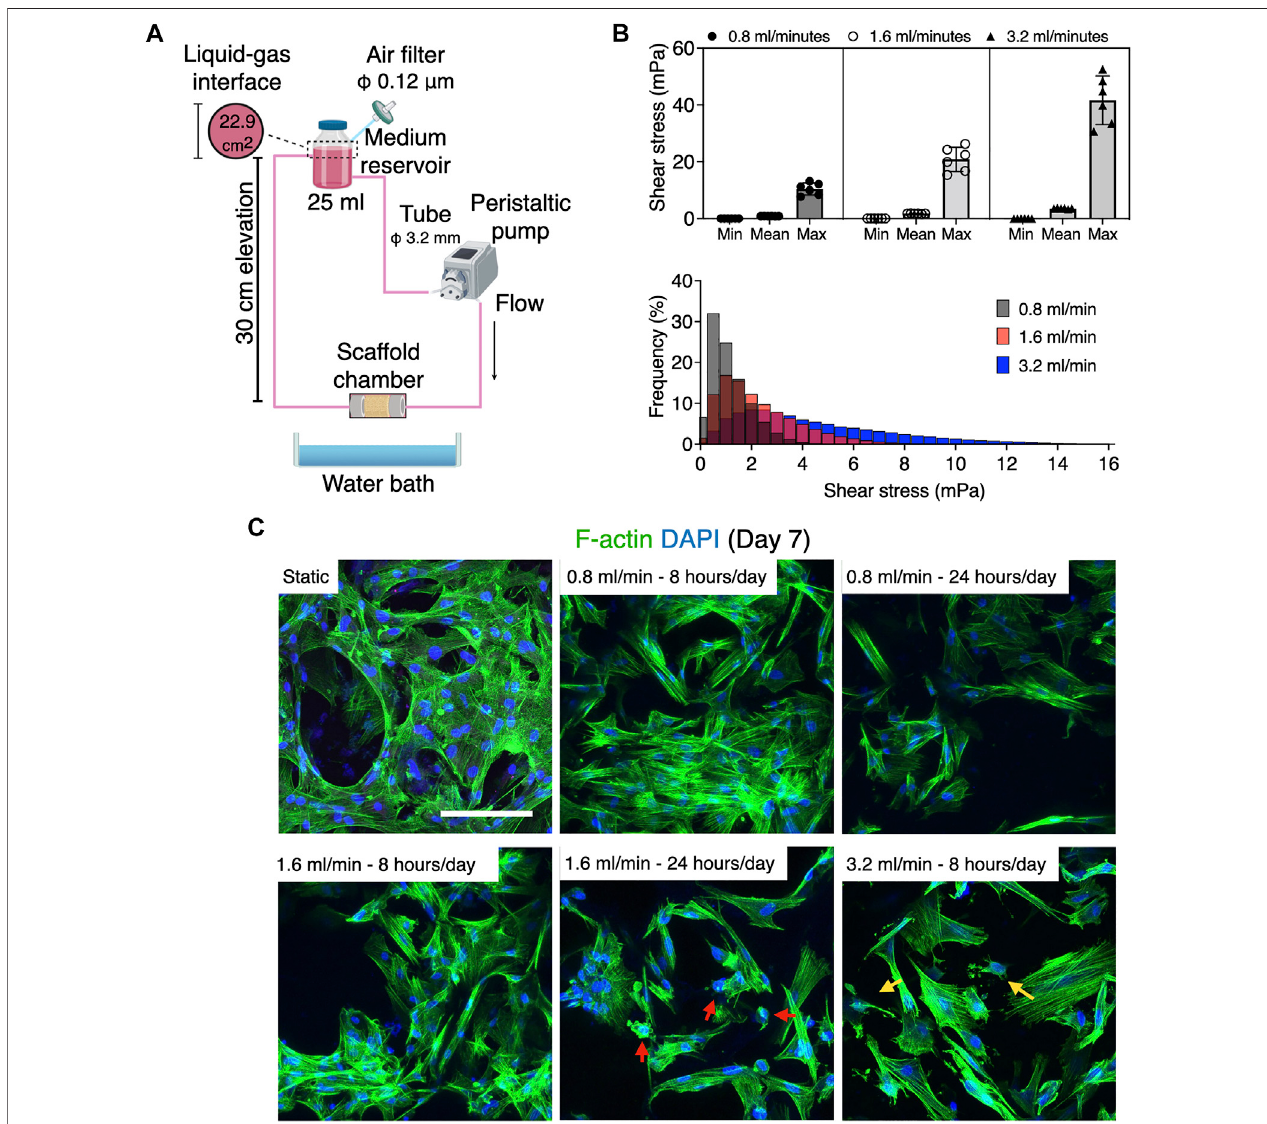
FIGURE 6 | Differential cell response to fl uid fl ow at 0.8, 1.6, and 3.2 ml/min. (A) Schematic illustration of experimental con fi guration. (B) Estimation of fl uid shear stress by in silico modeling using the microCT approach. The medium perfusion at 0.8, 1.6, and 3.2 ml/min in the present system exerted shear stress ranging from nearly 0to10 mPa,nearly 0 – 21 mPa,and nearly 0 – 41 mPa,respectively. The histogram shows themode valueofshearstressdistribution. (C) Fluorescence images of rBMSC exposed to fl uid fl ow. While the cells in the static control elongated homogeneously, those under perfusion tended to show more contracted morphology and more fi lamentous activity. Flow rate at 0.8 and 1.6 ml/min for 8 h supported cell growth, whereas perfusion for 24 h a day inhibited cell proliferation or induced apoptotic response (red arrows). A fl ow rate of 3.2 ml/min was found to fractionalize the cytoskeleton (yellow arrows). Scale bar: 100 µm.